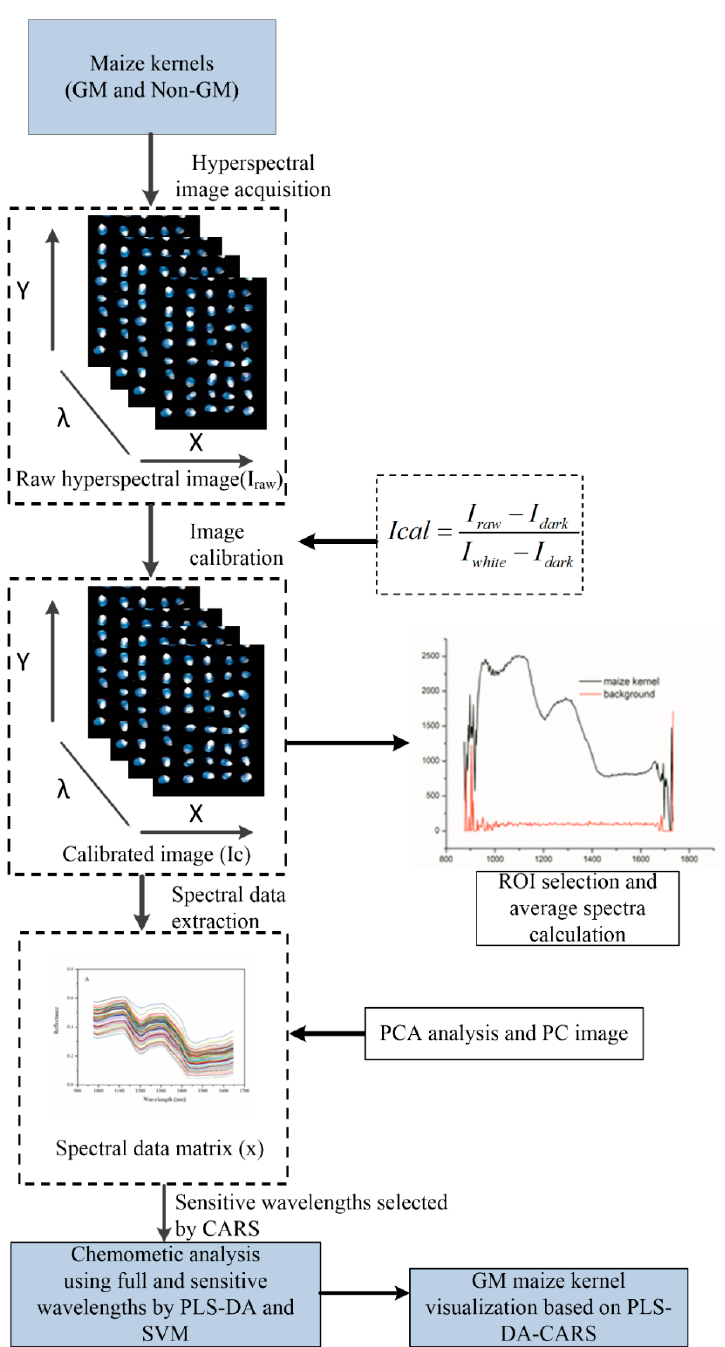
Figure 2. Flowchart of image processing and data analysis for discrimination of genetically-modified (GM) maize kernels. CARS: competitive adaptive reweighted sampling; PLS-DA: partial least squares discriminant analysis; ROI: region of interest; SVM: support vector machine.